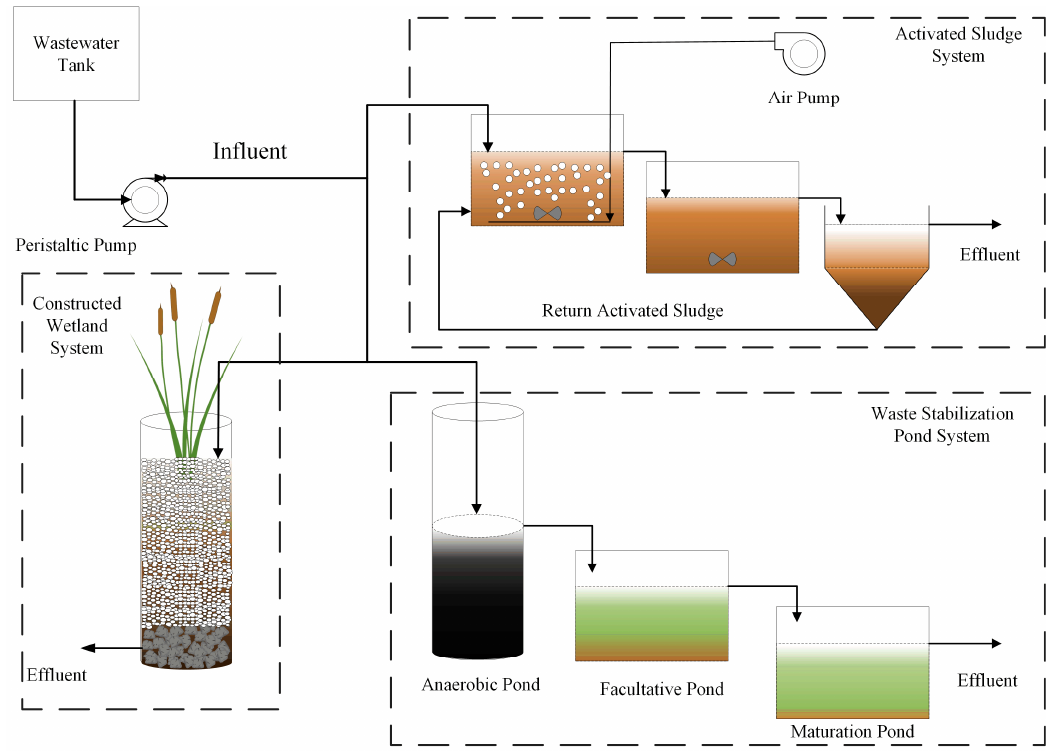
Figure 1. Schematic drawing of the three systems at lab scale. Each system was set up in triplicate located in the same room.